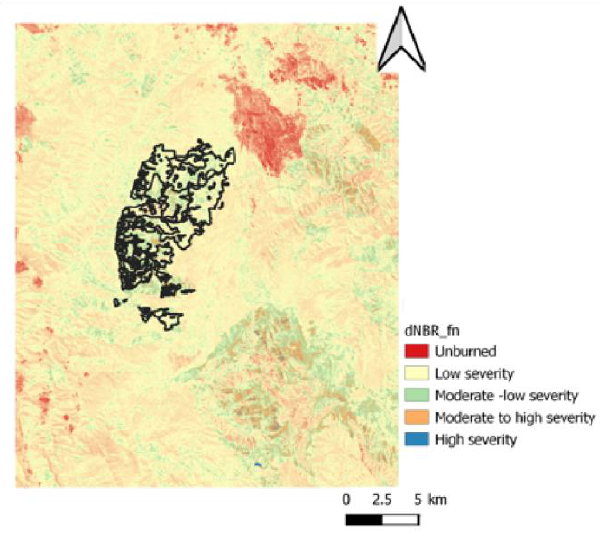
Figure 5. Difference normalized burnt ratio (d NBR ) from Landsat-8 of the